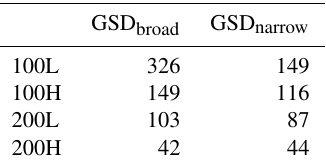
Table 4. Timing of the onset of transport, given in minutes from the start of the